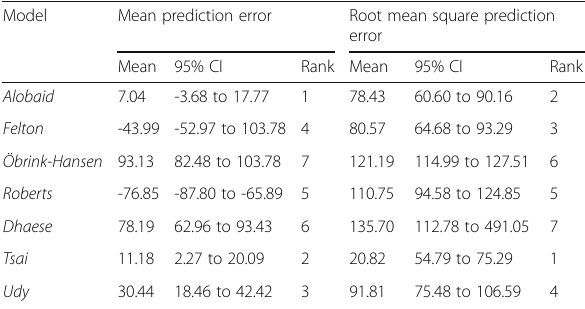
Table 1 (abstract 0017). Absolute prediction bias and imprecision versus observed levels of piperacillin